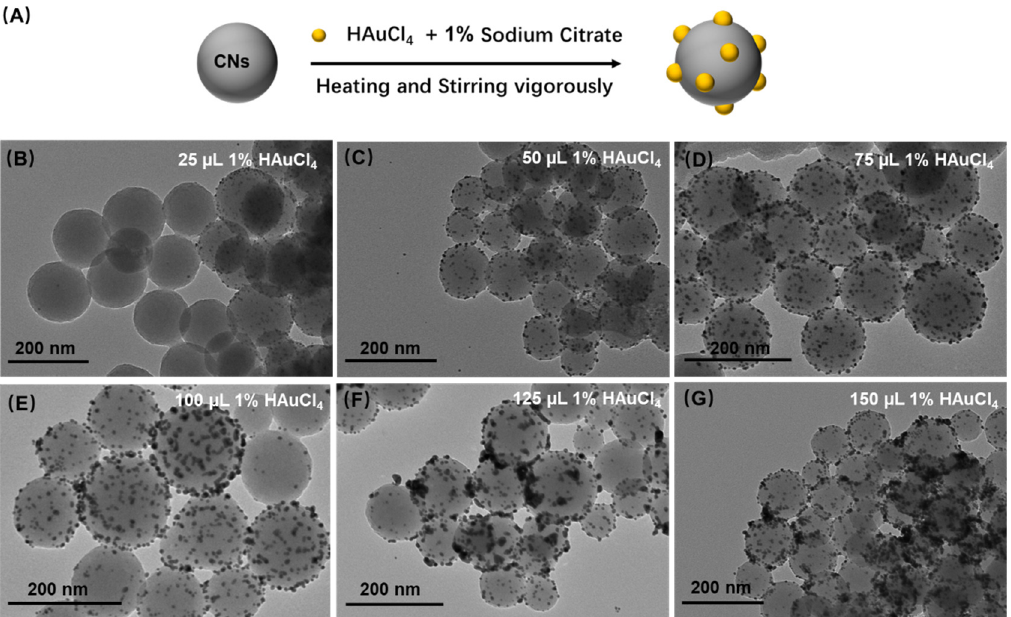
Figure 4. Synthesis of CGNs by hydrothermal method. ( A ) Schematic illustration of AuNPs deposited on CNs by hydrothermal method, and the corresponding TEM characterization of CGNs with different volume of 1% HAuCl 4 of ( B ) 25 µL, ( C ) 50 µL, ( D ) 75 µL, ( E ) 100 µL, ( F ) 125 µL, and ( G ) 150 µL.